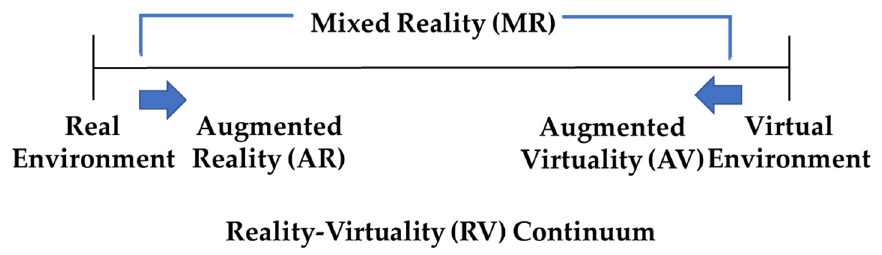
Figure 1. Milgram’s reality-virtuality continuum [3].